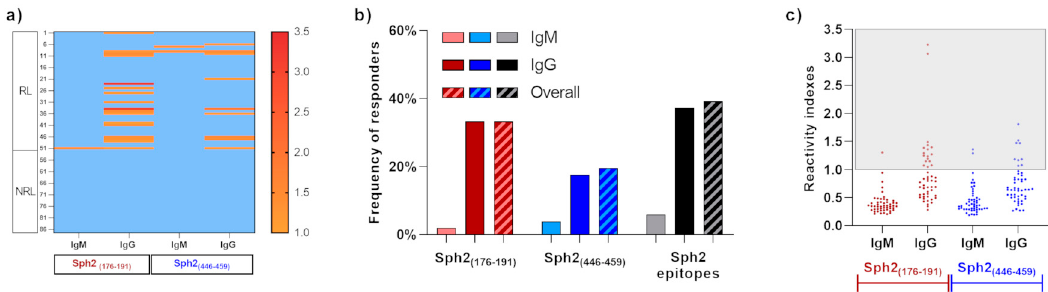
Figure 2. Evaluation of natural immunogenicity of predicted epitopes. ( a ) Heatmap of IgM and IgG reactivity indexes against synthetic epitopes. Values higher than 1 represent responder individuals and were indicated in the color scale, and non-responders were indicated by a light blue color. ( b ) Frequencies of IgM (light color), IgG (dark color), and overall (striped bar) responders to Sph2 (176-191) (red bars), Sph2 (446-459) (blue bars), and responders to at least one Sph2 epitope (gray/black bars). ( c ) IgM and IgG reactivity indexes against Sph2 (176-191) (red points) and Sph2 (446-459) (blue points). Responders to peptides were highlighted by the gray square.